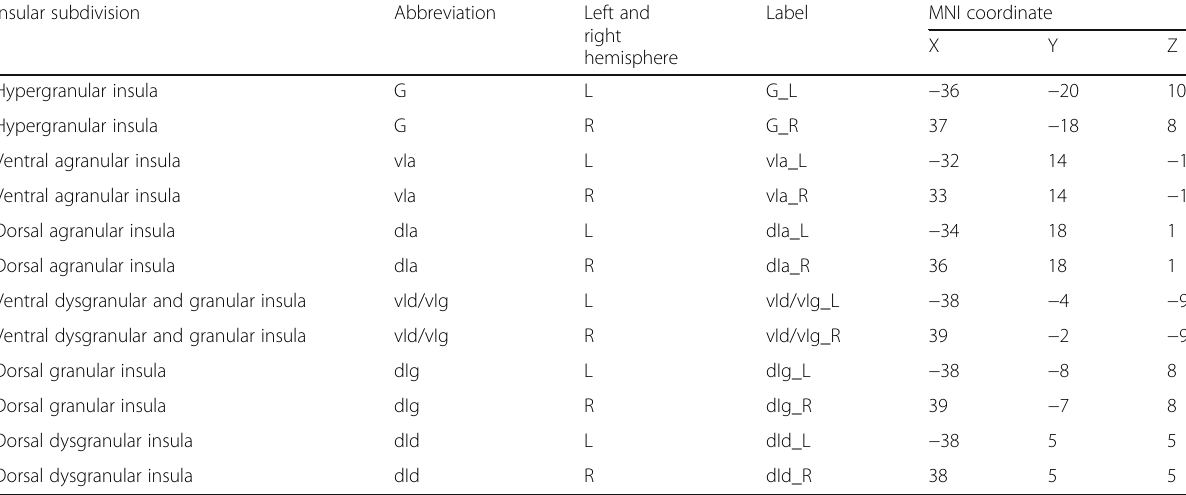
Table 1 MNI coordinates of the 12 insular subdivisions Insular subdivision